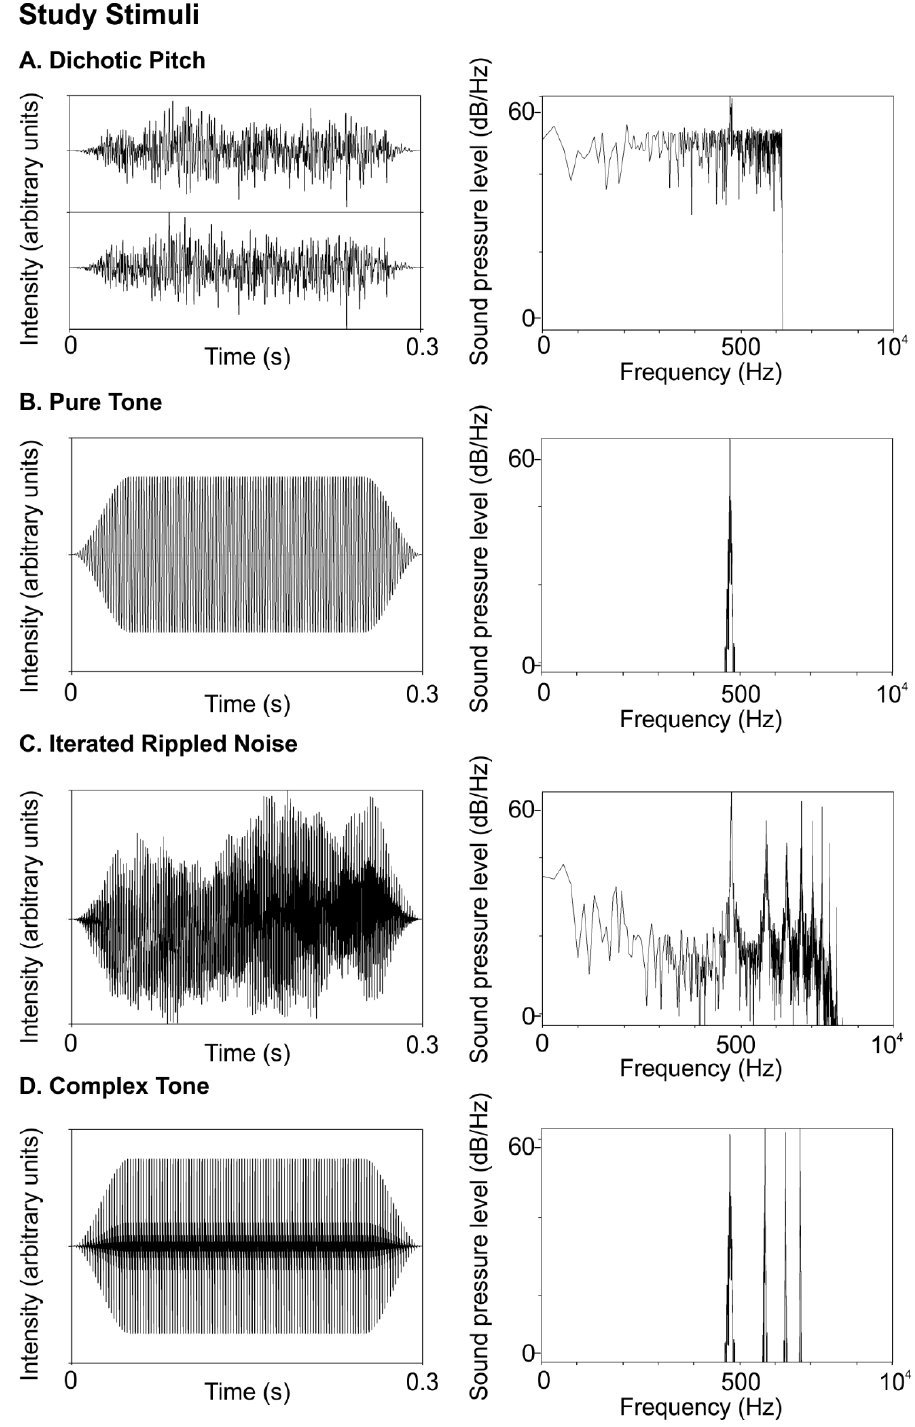
Figure 1. Study stimuli. Each row shows the 440 Hz stimulus waveform (left panel) and spectrum on a logarithmic frequency scale (right panel). ( A ). Dichotic pitch with an interaural phase shift of 440 Hz, ( B ). Pure tone, ( C ). Iterated rippled noise with a 64 iteration of delay and add at 1/440 s. ( D ). Complex tone with three overtone harmonics.